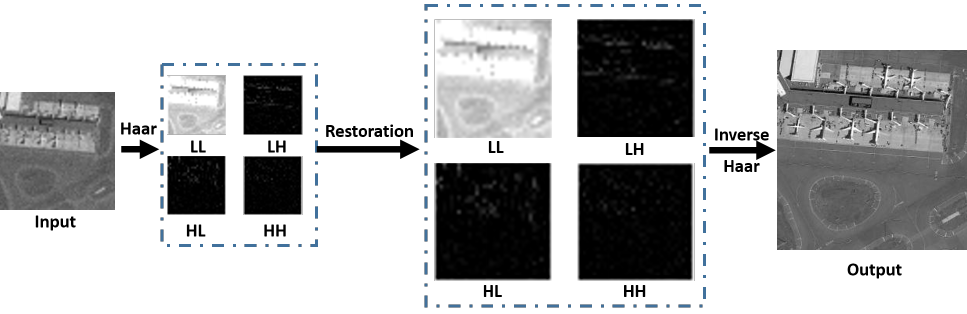
Figure 3. The main steps of the generative part in RRDGAN.